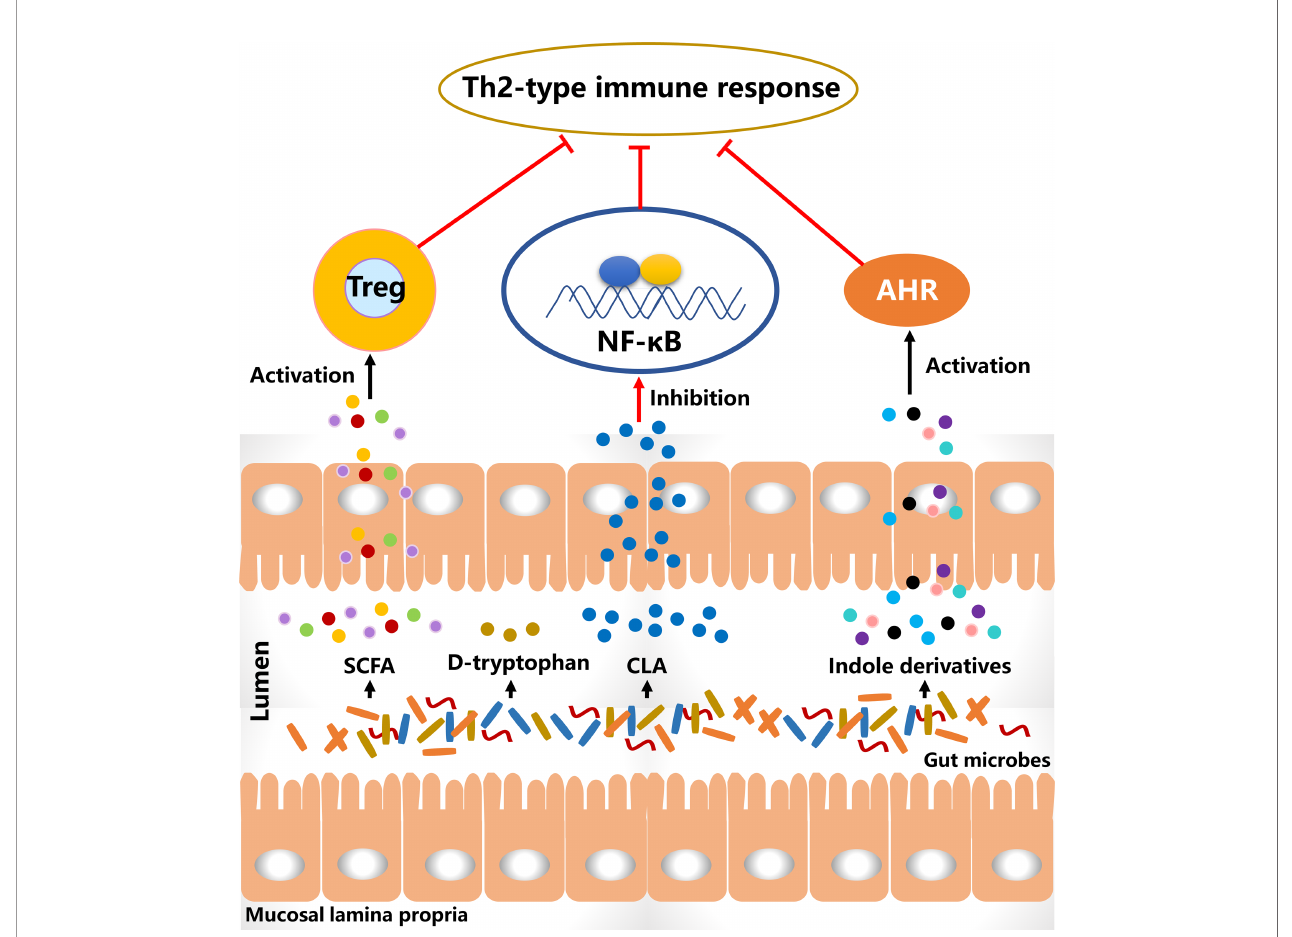
FIGURE 2 | The diagram of t he potential effective substances for suppressing Th2-type immune responses. CLA, conjugated linoleic acid; SCFA, short-chain fatty acid; Treg, regulatory T